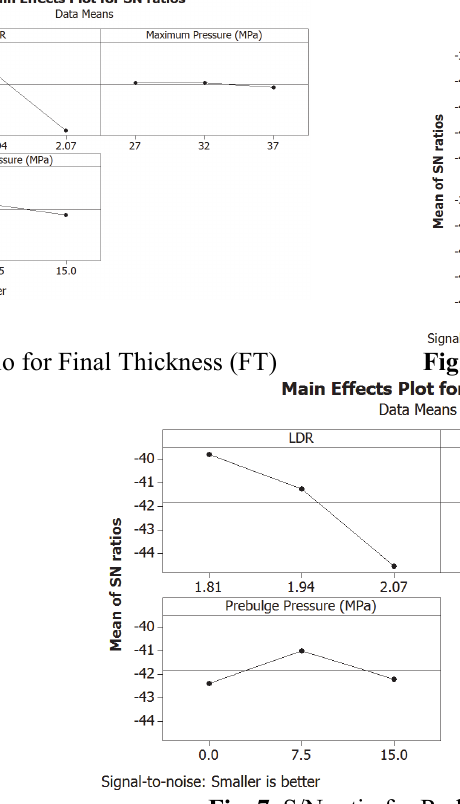
Fig. 7. S/N ratio for Radial Stress (RS)